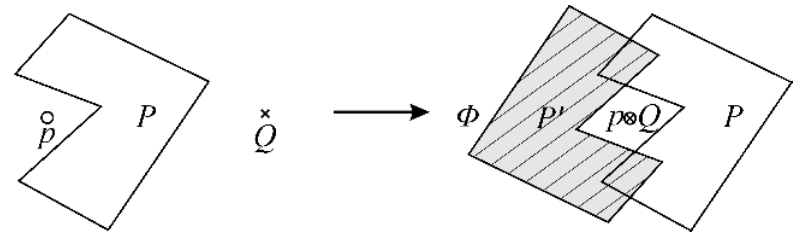
Figure 2. Region of movability for polygon P with point Q as the background feature.